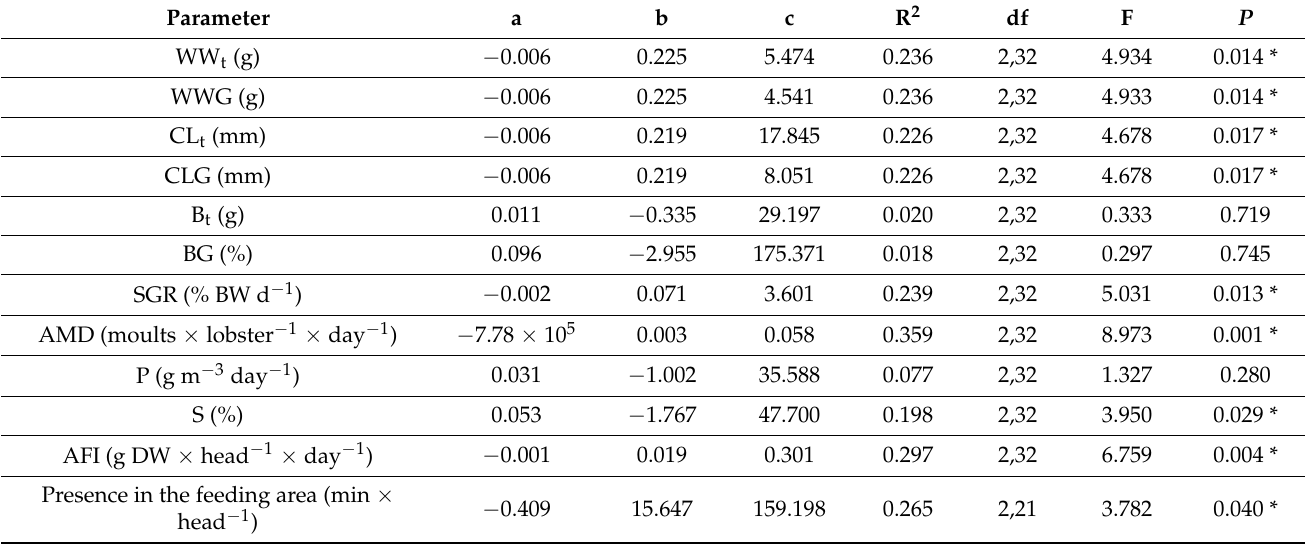
Table 1. Quadratic regression details (y = ax 2 + bx + c). Quadratic regressions describe the influence of feed frequency on the following parameters: final wet weight (WW t ), wet weight gain (WWG), final carapace length (CL t ), carapace length gain (CLG), final biomass (B t ), biomass gain (BG),